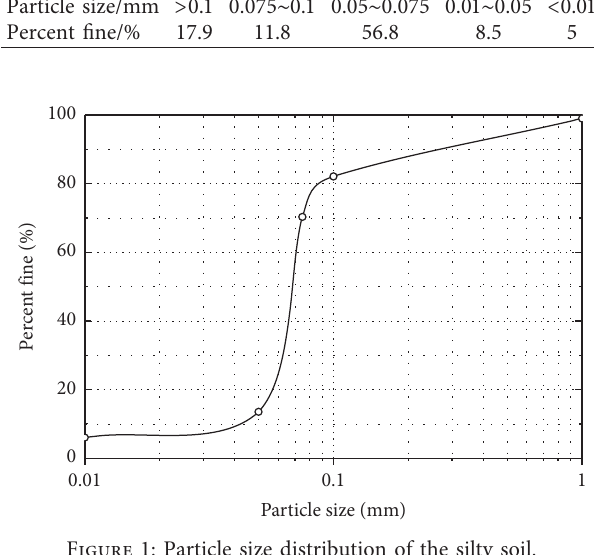
Table 1: Soil particle size distribution.